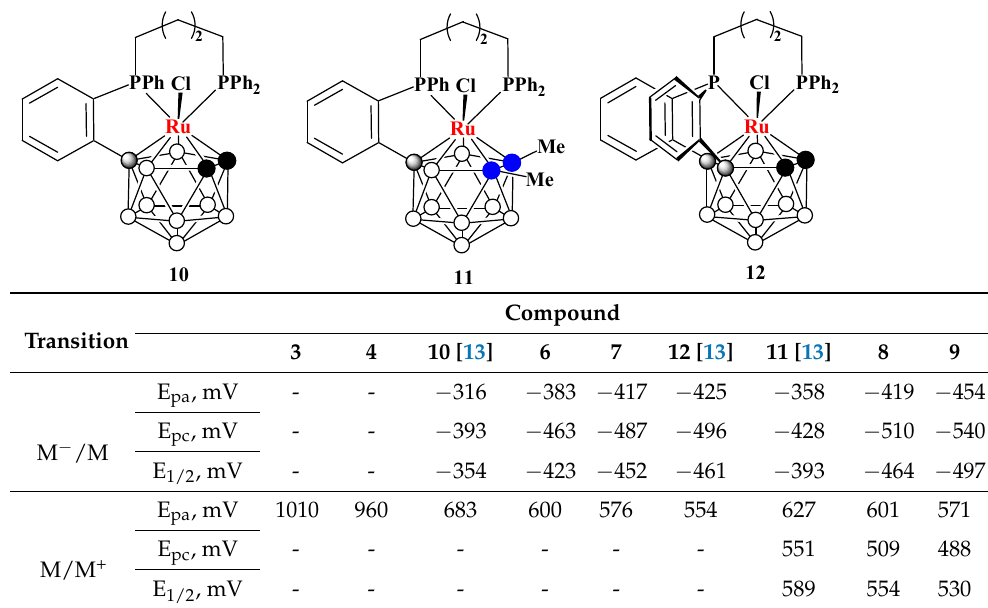
Table 2. The results of electrochemical studies of the discussed ruthenacarboranes.